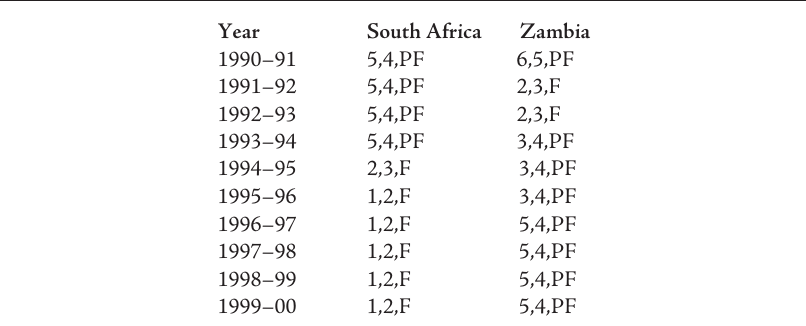
Table 8 – Freedom House, Annual Survey of Freedom Scores, 1990–1991 through